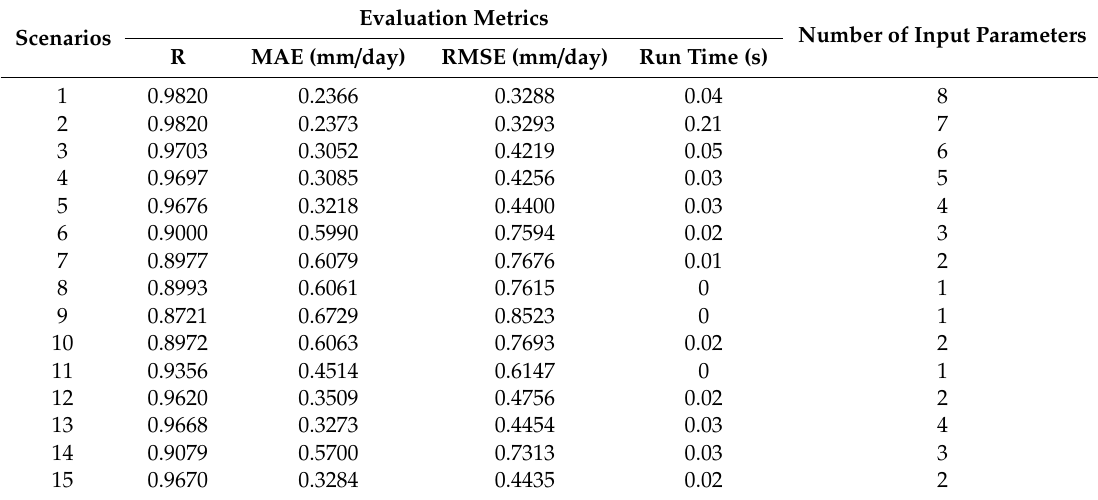
Table 7. REPTree model results for di ff erent scenarios.